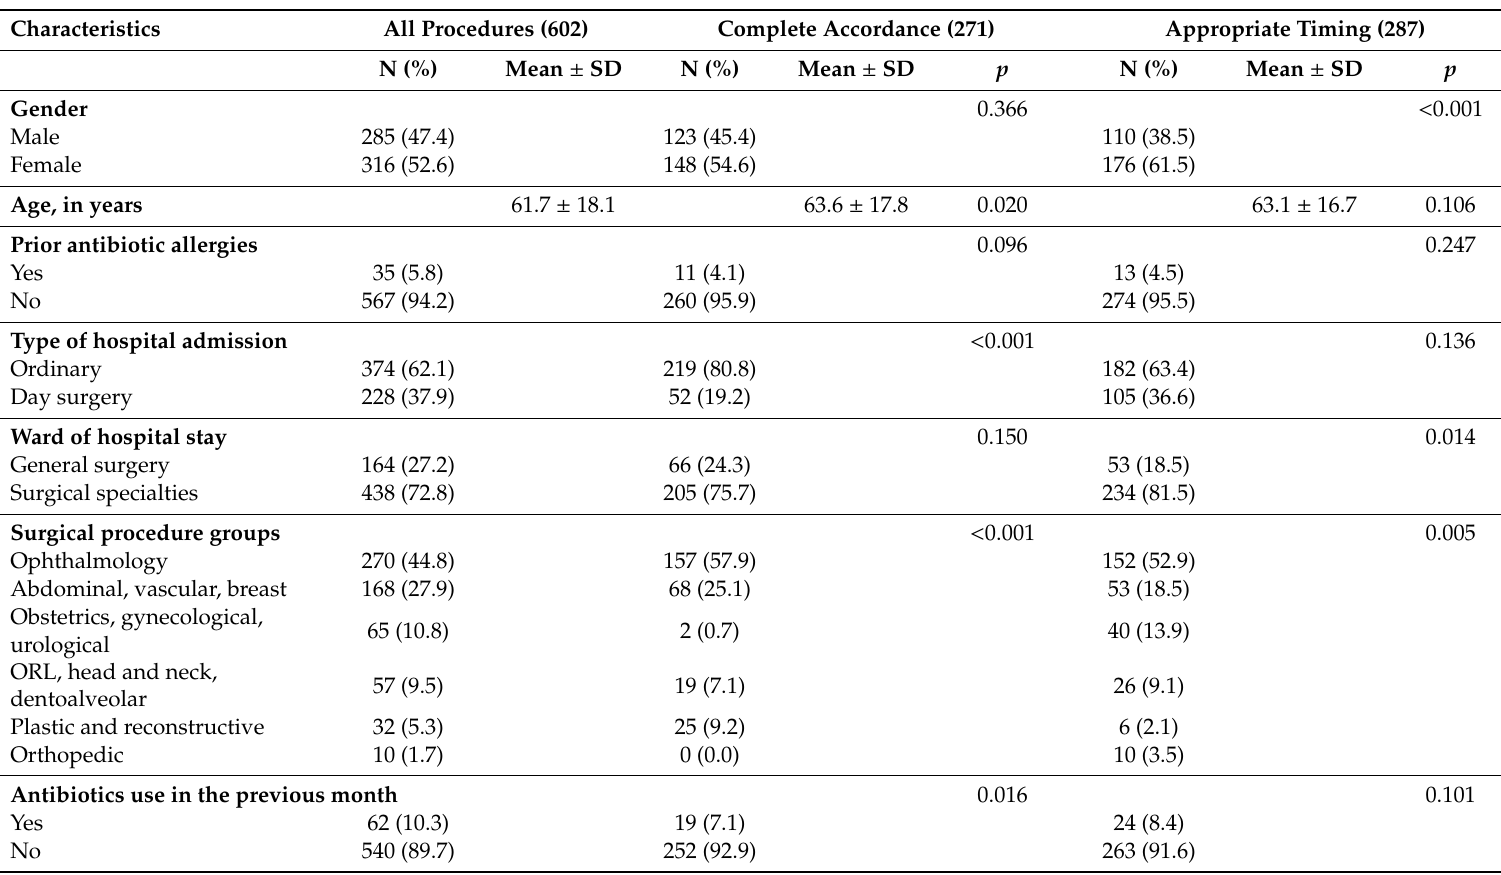
Table 1. Demographic, clinical, and admission characteristics of patients according to surgical antibiotic prophylaxis (SAP) approach.